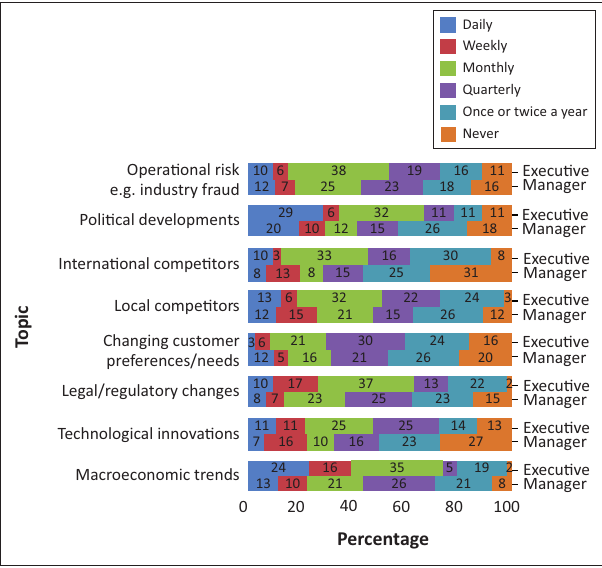
FIGURE 1: Comparison of frequency preference to receiving intelligence on specific topics.